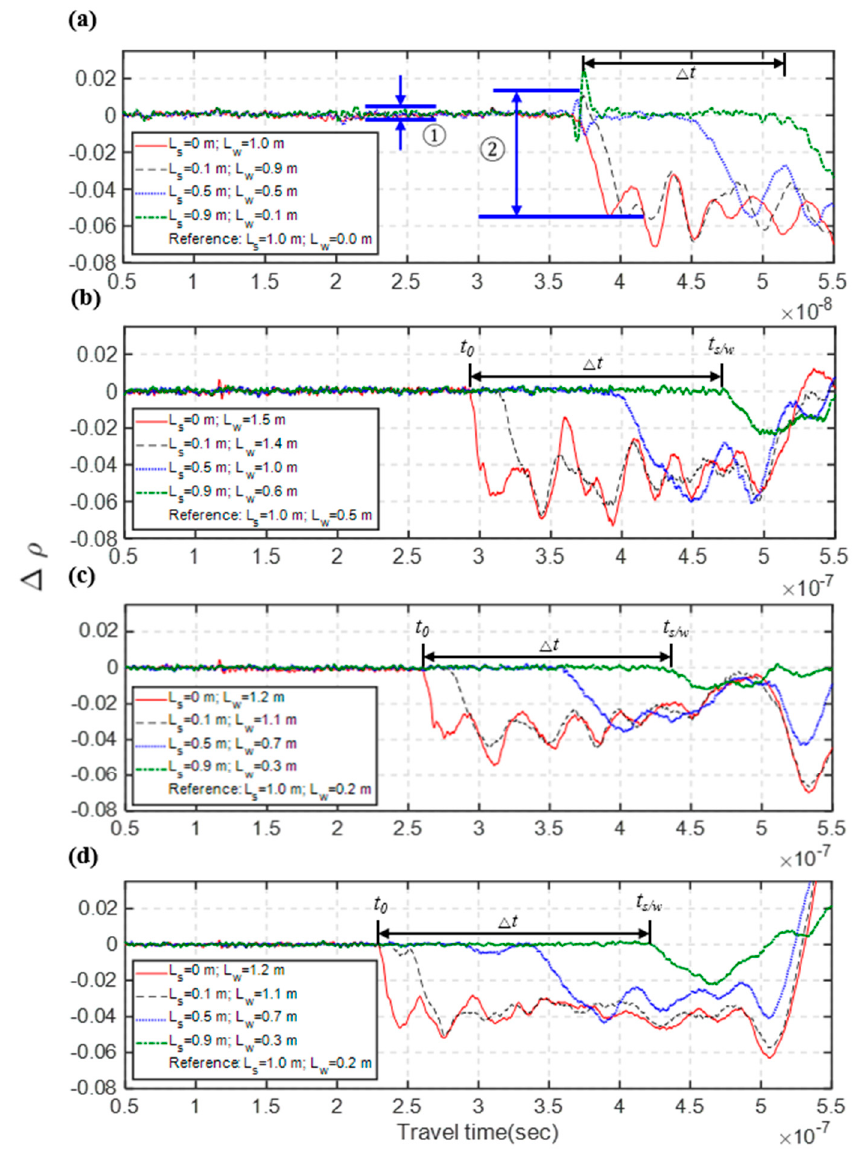
Figure 4. Results of differential waveform analysis in the scour sandbox experiment: ( a ) original TDR sensing cable with definitions of SNR and travel time in the sediment section; ( b ) Type I sensing waveguide; ( c ) Type II sensing waveguide; and ( d ) Type III sensing waveguide.